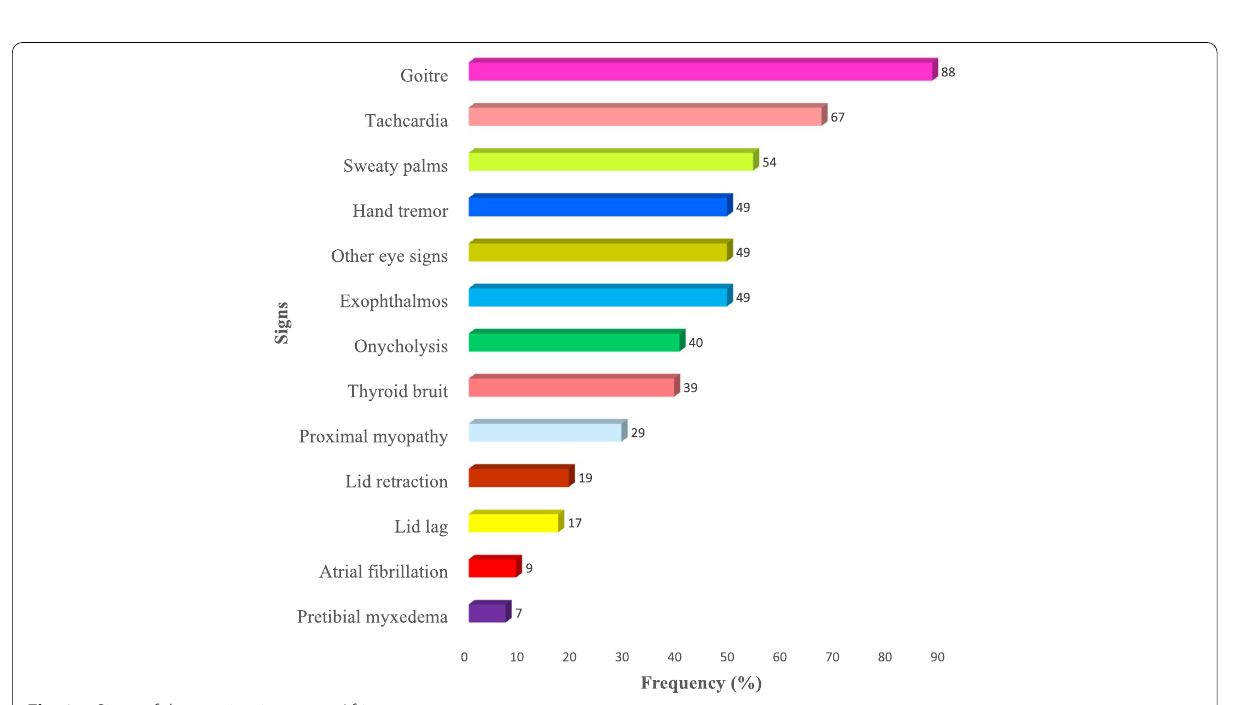
Fig. 21 Signs of thyrotoxicosis among